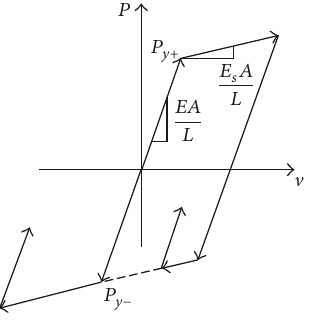
Figure 5: Truss element model with equal axial capacity in tension and compression [7, 23].